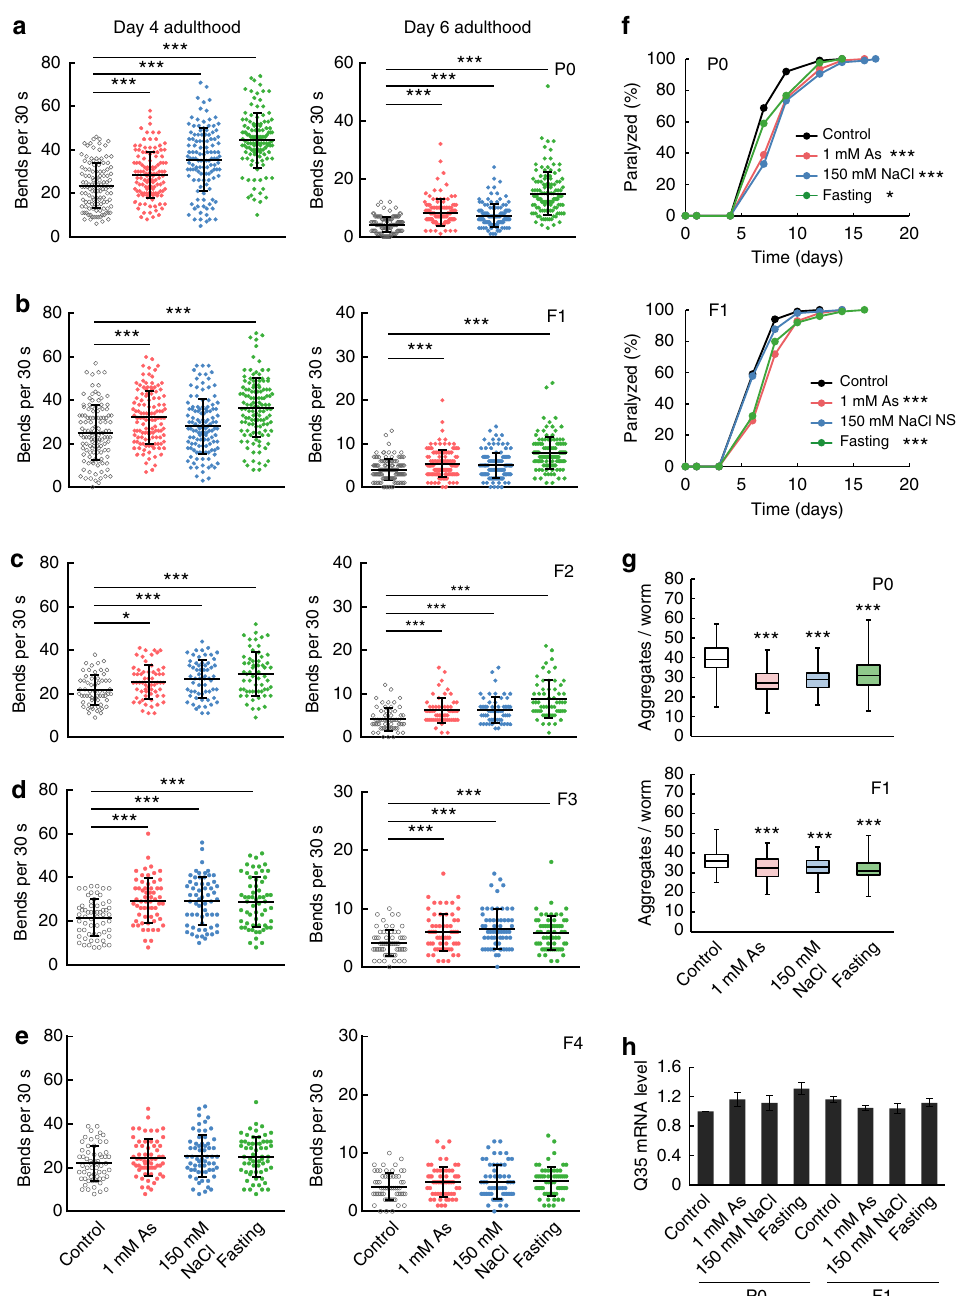
Figure 2 | Transgenerational inheritance of increased resistance to proteotoxicity. ( a – e ) Thrashing rate of the stress-exposed P0 transgenic animals expressing polyQ ( a ), self-fertilized F1 ( b ), F2 ( c ), F3 ( d ) and F4 ( e ) descendants compared with control groups (left, day 4 adulthood; right, day 6 adulthood). Each point represents the number of the body bend of a single animal over a period of 30s. Two or three independent experiments are integrated into each scatter graph ( n ¼ 120 for a and b , n ¼ 60 for c – e ). Mean ± s.d., * P o 0.05, ** P o 0.01, *** P o 0.005, Mann–Whitney U test. ( f ) Rate of paralysis of the stressed P0 (upper) and the self-fertilized F1 (lower) polyQ animals. Representative data of two independent experiments are shown. The sample size and P values are presented in Supplementary Table 2. NS, not statistically significant; * P o 0.05, *** P o 0.005, log-rank test. ( g ) Number of polyQ protein aggregates in the stressed P0 (upper) and the F1 (lower) on day 4 adulthood. Two independent experiments are integrated into each graph ( n ¼ 100). Box plots represent median and interquartile ranges, and whiskers represent minimum to maximum values. *** P o 0.001, Mann–Whitney U test. ( h ) Relative expression levels of Q35::YFP transgene. Statistical significance was calculated by Student’s t -test. Error bars represent the mean ± s.e.m. of three independent experiments. No statistical significance was observed in each sample compared with the P0